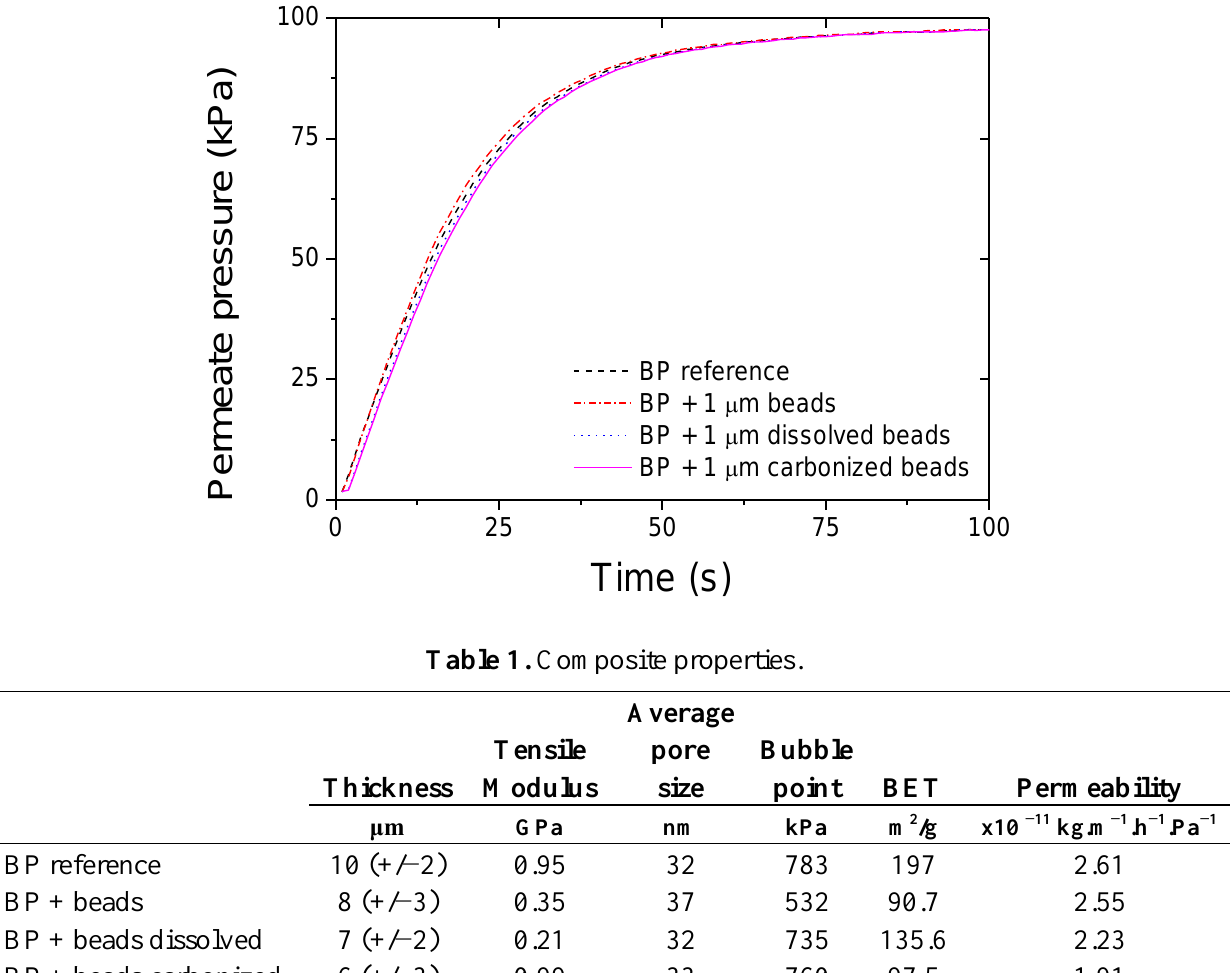
Figure 6. Air permeation across the BP samples.